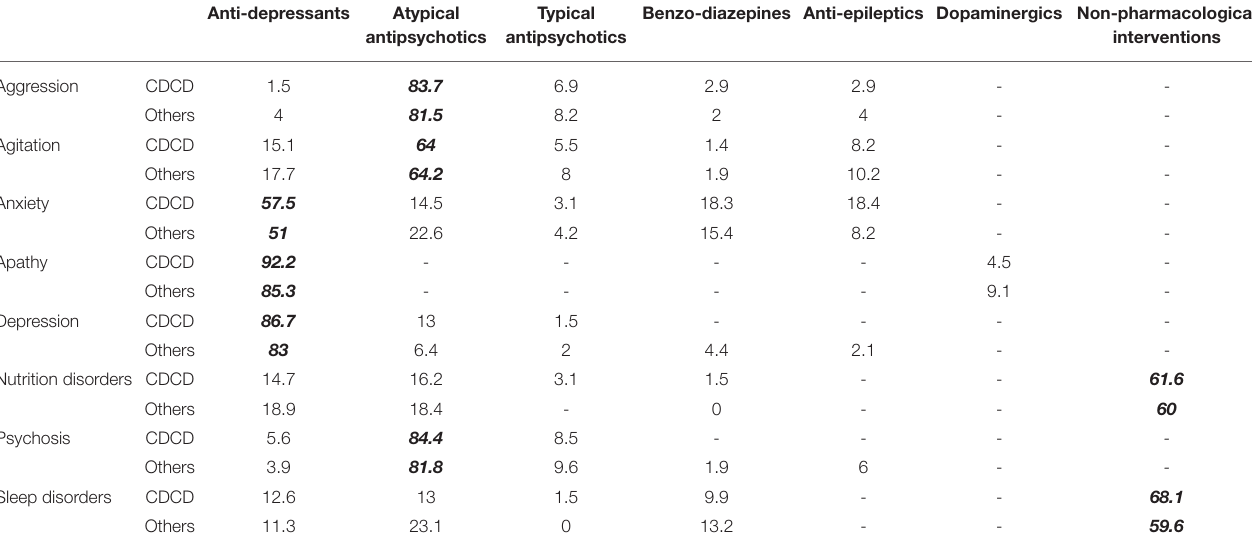
TABLE 2 | A comparison of first choice treatment options for neuropsychiatric symptoms between centers for cognitive disorders and dementia (CDCD) and other settings. Anti-depressants